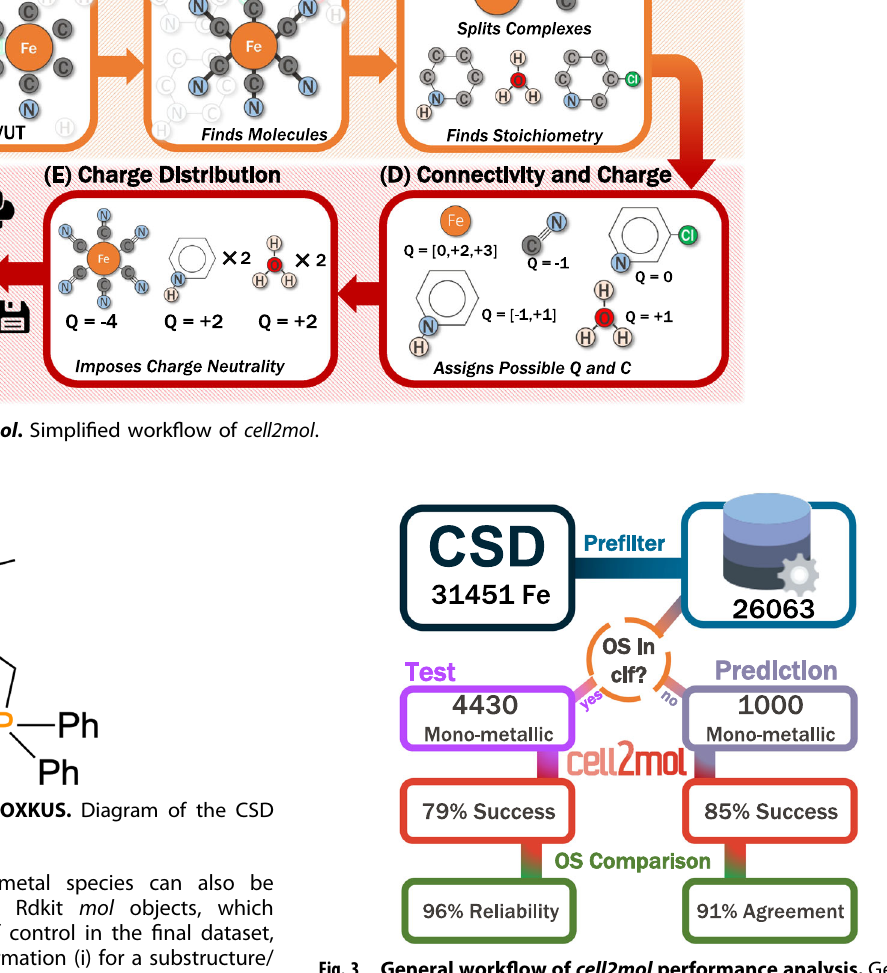
Fig. 3 General work fl ow of cell2mol performance analysis. General work fl ow to set up the success rate and reliability of cell2mol , including values for the Fe-based database of mono-metallic